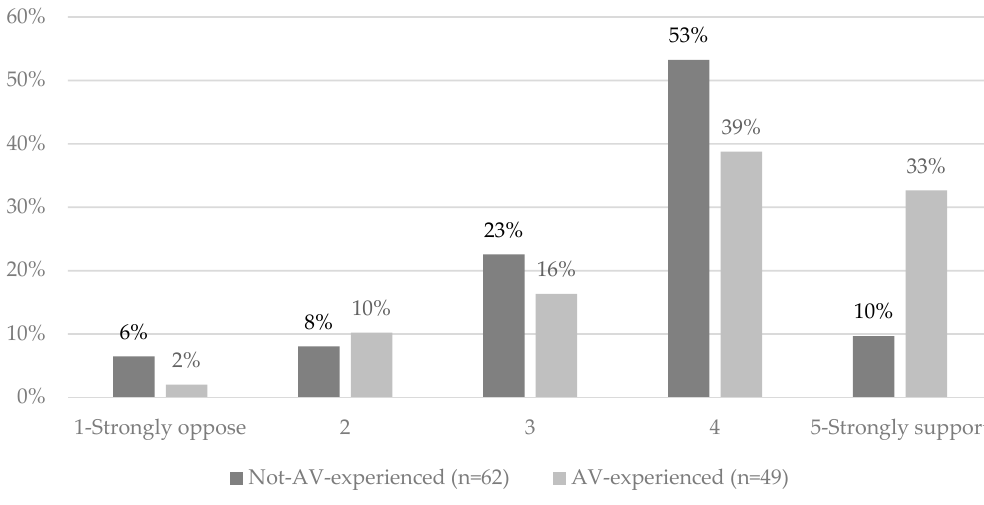
Figure 3. General opinion towards driverless trains.